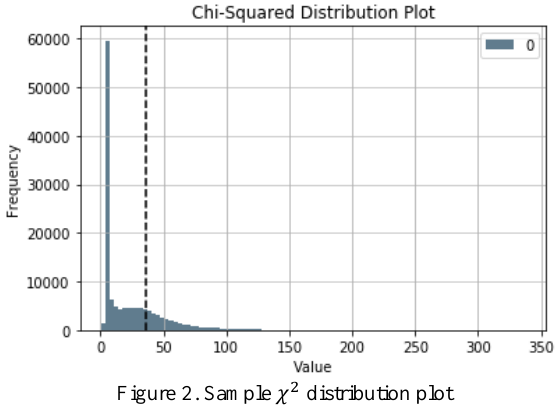
Figure 2. Sample 𝜒 2 distribution